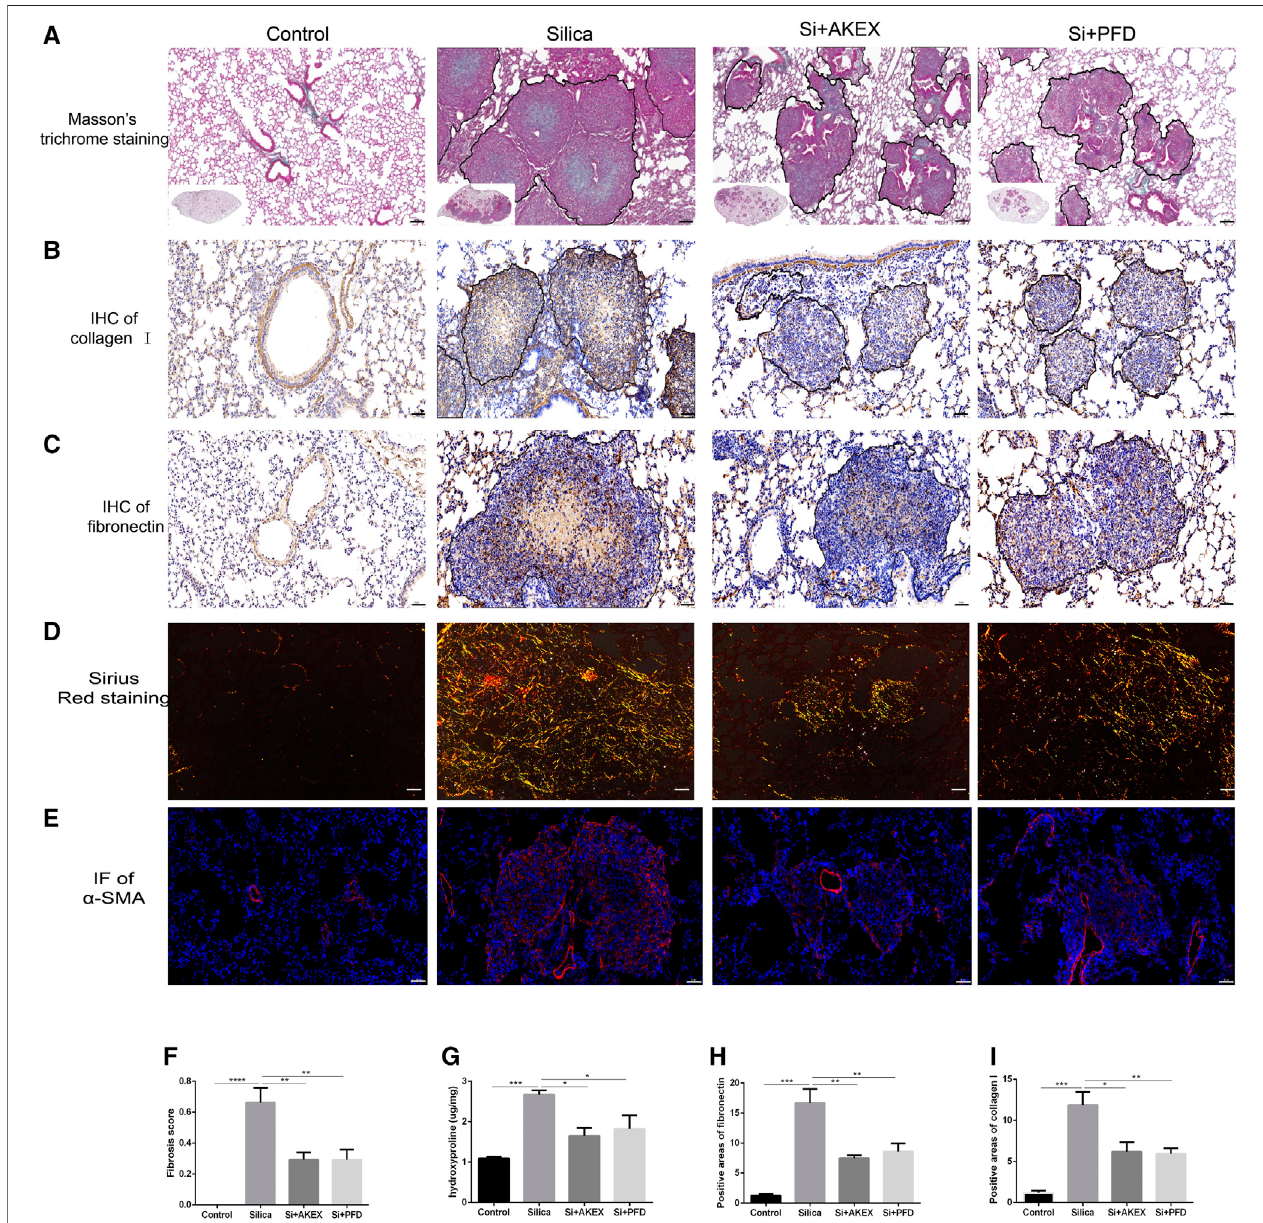
FIGURE 3 | AKEX0011 ameliorated pulmonary fi brosis in the early therapeutic silicosis model. (A) Masson ’ s trichrome staining of lung sections (original magni fi cation ×100). ( B,C) IHC staining of collagen I and fi bronectin on lung sections (original magni fi cation ×200). (D) Sirius red staining on lung sections (original magni fi cation×200). (E) IFstainingof α -SMAonlungsections(originalmagni fi cation×200). (F) FibrosisscorebasedonMasson ’ strichromestaining(n=5). (G) Levelsof HYP in lung tissues (n = 3 or 5). (H,I) Quanti fi cation of collagen I and fi bronectin-positive areas based on images in (B,C) (n= 4). All data were presented as mean ± SEM; * p < 0.05, ** p < 0.01, *** p < 0.001, and **** p <